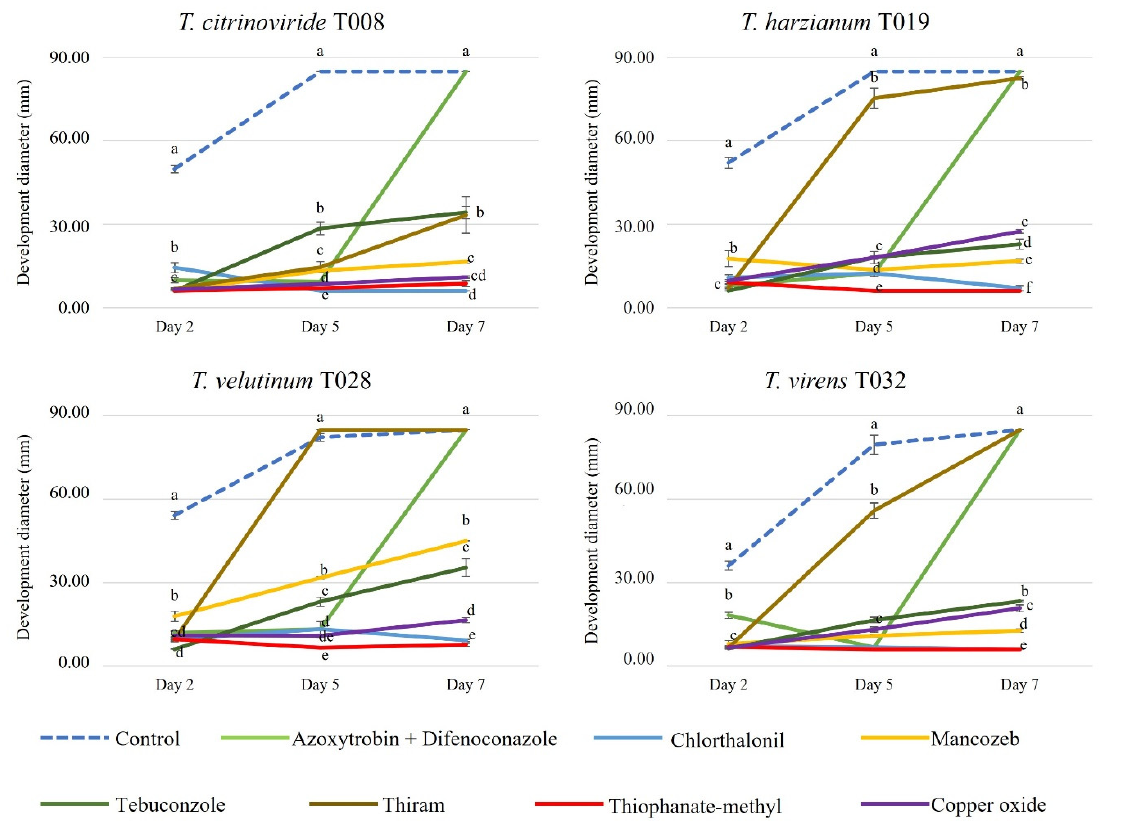
Figure 6. Development of autochthonous Trichoderma strains (diameter of growth, mm) in media with synthetic fungicides at 2, 5 and 7 days after inoculation. Blue color: control Petri dish. Light green color: Azoxistrobin 20% + Difenoconazole 12.5%. Blue color: Chlorthalonil 50%. Yellow color: Mancozeb 80%. Dark green color: Tebuconazole 25%. Brown color: Thiram 80%. Red color: Methyl thiophanate 45%. Purple color: Copper 75%. The concentrations of each pesticide are specified in Table 2. Upper and lower error bars are represented and indicate standard error of the mean showing the accuracy of the calculations. Different letters indicate significant differences between synthetic fungicides (ANOVA, LSD, p < 0.05).